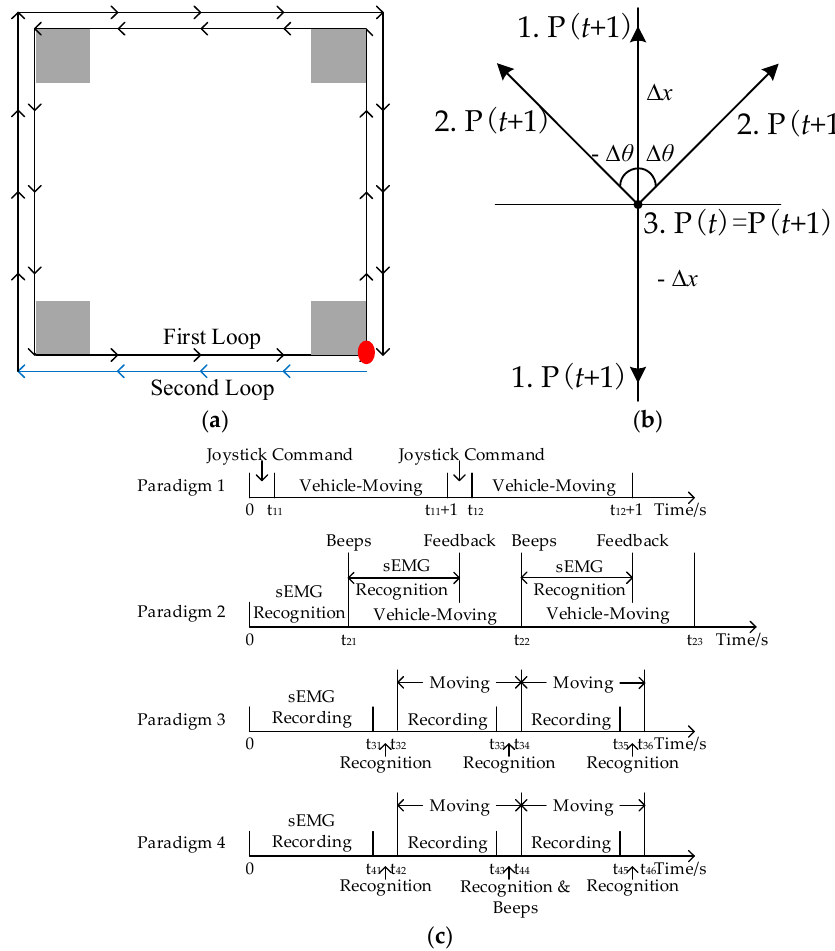
Figure 5. ( a ) Environment and obstacle maps. It contains the forward information (black vectors), backward information (blue vectors), starting point (red circle) and obstacle location (gray areas); ( b ) Three possibilities of the location update for Paradigm 1 and 2 (‘1’ denotes the straight-line movements, ‘2’ denotes the rotation movements, and ‘3’ is no movements); ( c ) The protocol for each paradigm. The onset of each real-time session is presented as the reference time point of 0 s.